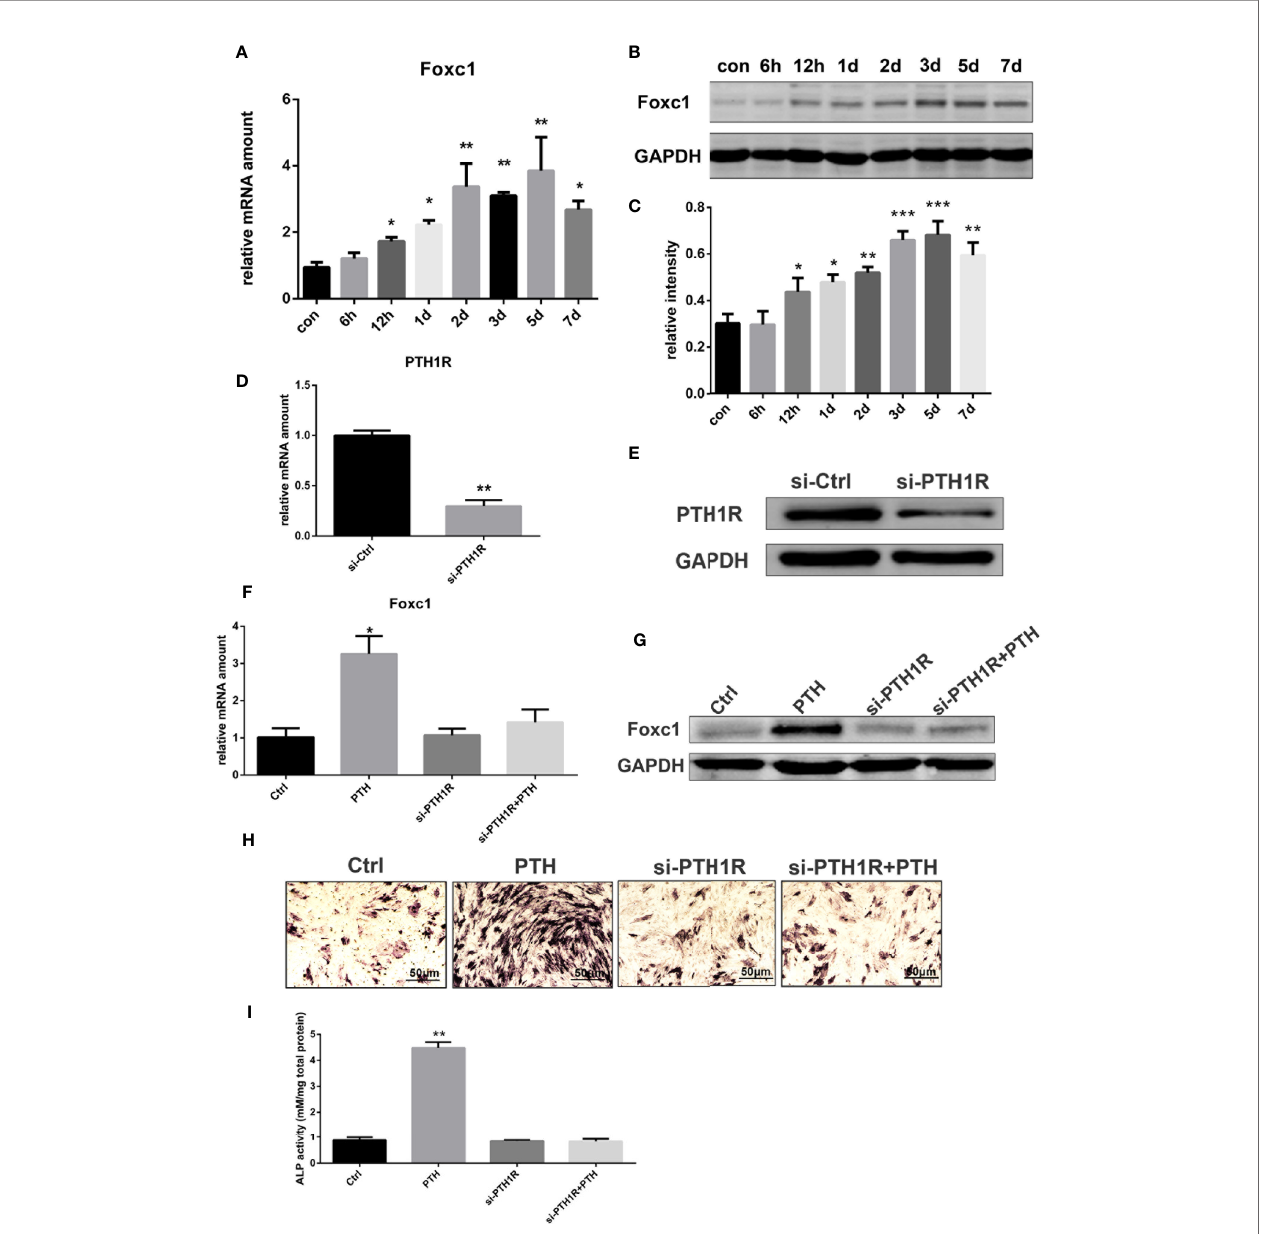
FIGURE 1 | Expression of Foxc1 was increased by intermittent PTH treatment and PTH1R silencing inhibited the expression of Foxc1 and PTH-induced osteogenic differentiation. (A) mRNA expression level of Foxc1 at different time points induced by intermittent PTH treatment for 7 days in rBMSCs. (B, C) Protein expression level and quantitative analysis of Foxc1 at different time points by intermittent PTH treatment for 7 days in rBMSCs. (D, E) PTH1R mRNA and protein expression at 48 h after transfection in rBMSCs in control group (si-Ctrl) and PTH1R silencing group (si-PTH1R). (F, G) Foxc1 mRNA and protein expression on the 3rd day in control group (Ctrl), intermittent PTH treatment group (PTH), PTH1R silencing group (si-PTH1R) and PTH1R silencing group with intermittent PTH treatment (si- PTH1R+PTH). (H, I) ALP staining and its quantitative analysis on the 7th day in control group (Ctrl), intermittent PTH treatment group (PTH), PTH1R silencing group (si-PTH1R) and PTH1R silencing group with intermittent PTH treatment (si-PTH1R+PTH). Scale bar = 50 m m. * p < 0.05, ** p < 0.01, *** p <